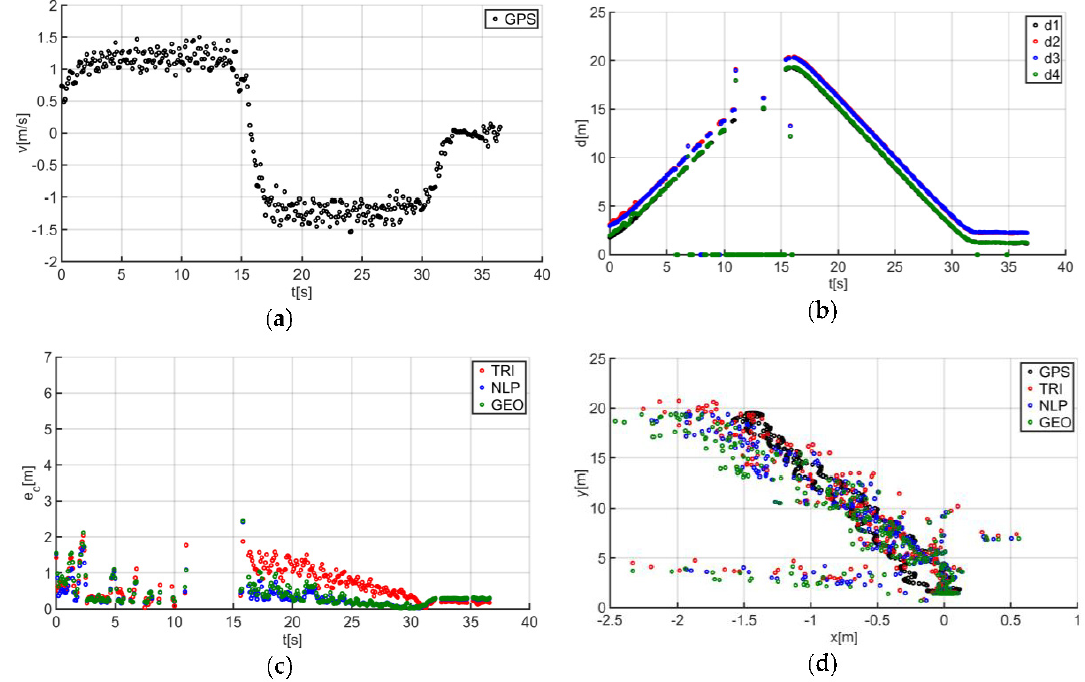
Figure 17. Test results no. 4: ( a ) human guide speed v p (t) and ( b ) filtered distance from anchors d i (t), i = 1, 2, 3, 4; ( c ) course of total location errors e c (t) and ( d ) location of the human guide y p (t) = f(x p (t)).